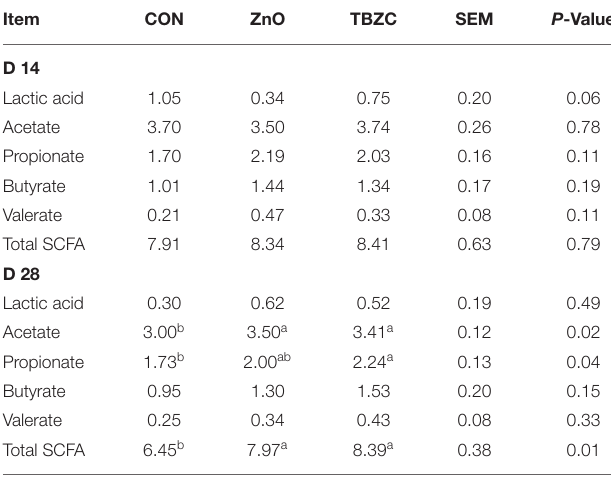
TABLE 3 | Effects of tetrabasic zinc chloride on apparent total tract digestibility of nutrients and fecal zinc concentration in weaned piglets (%). Item CON ZnO TBZC SEM P -Value